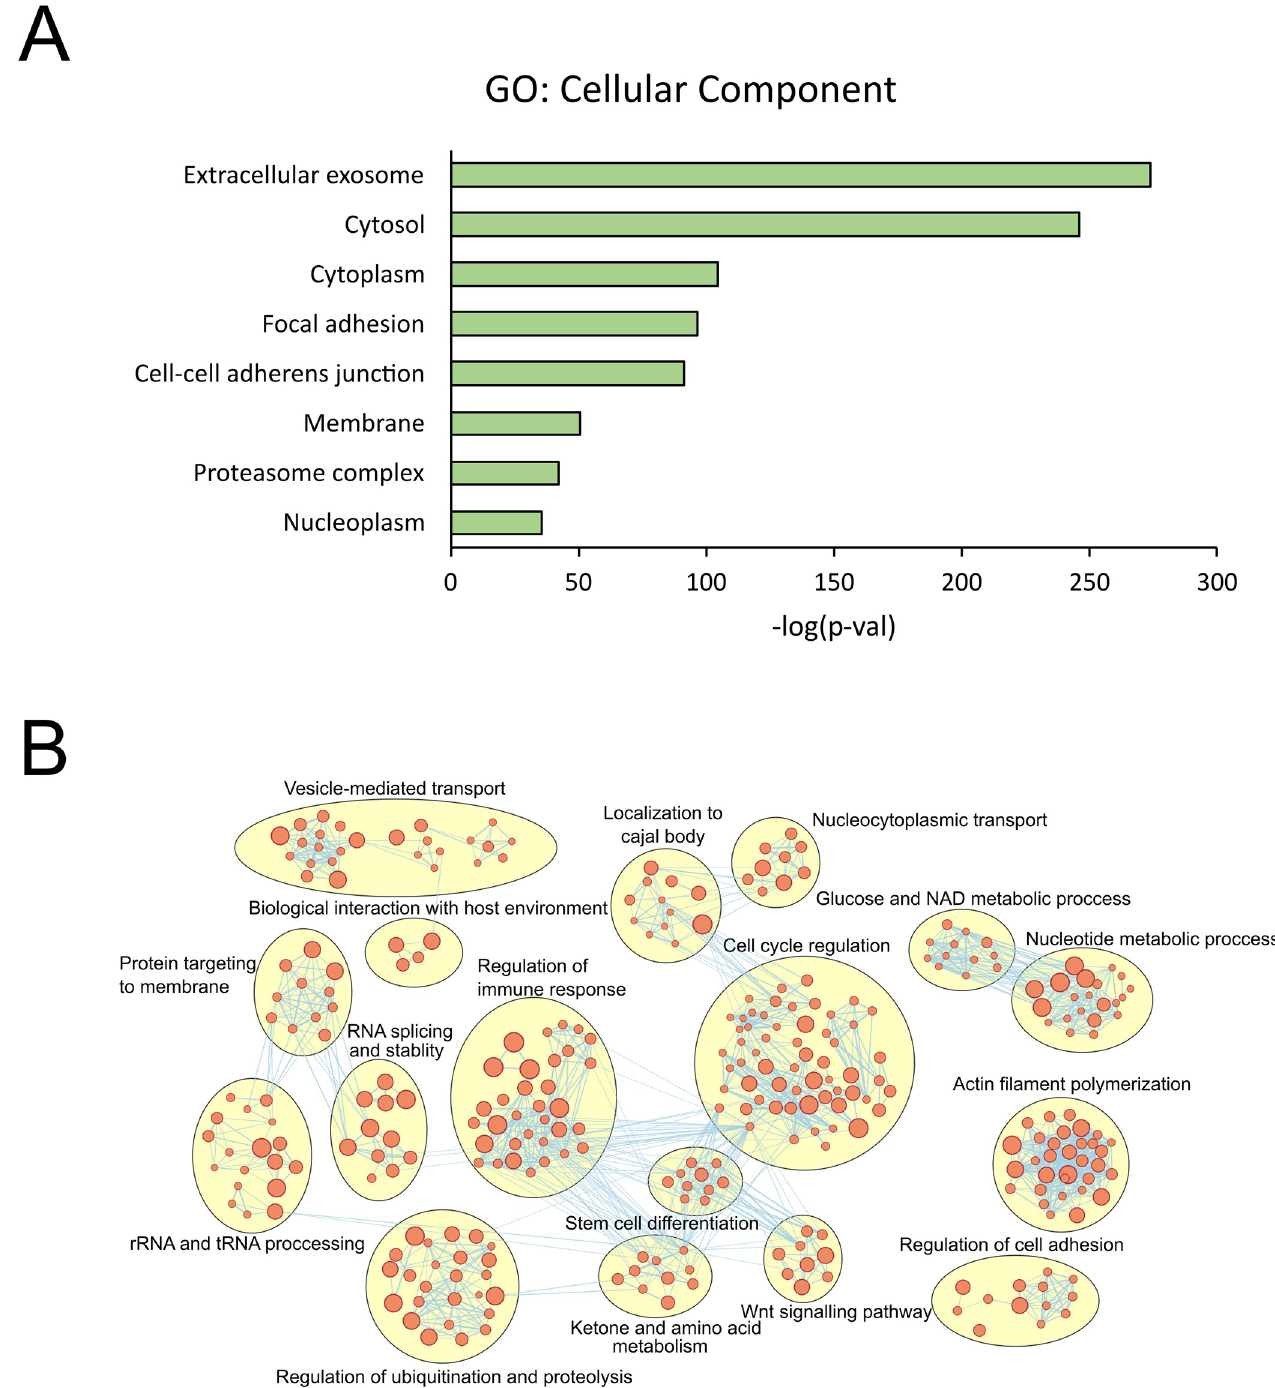
Fig 4. Proteomic analysis of human AFSC-derived CM . (A) cellular component gene ontology enriched in the secretome of hAFSC-CM. (B) Network clustering showing the clusters of biological processes (from gene ontology) enriched in the secretome of hAFSC-CM.